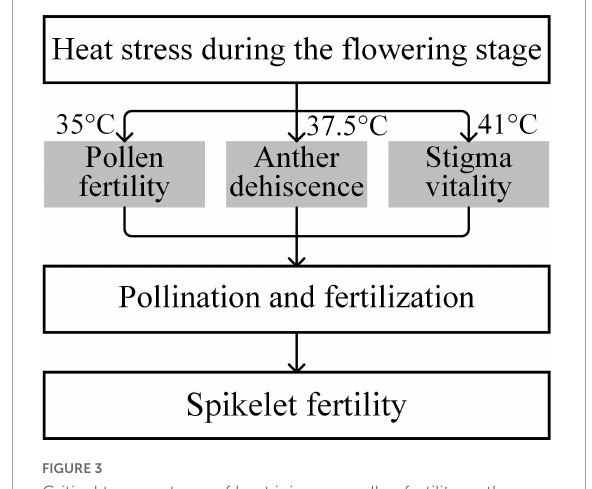
FIGURE3 Critical temperatures of heat injury on pollen fertility, anther dehiscence, and stigma vitality (adapted from Wu, 2016).